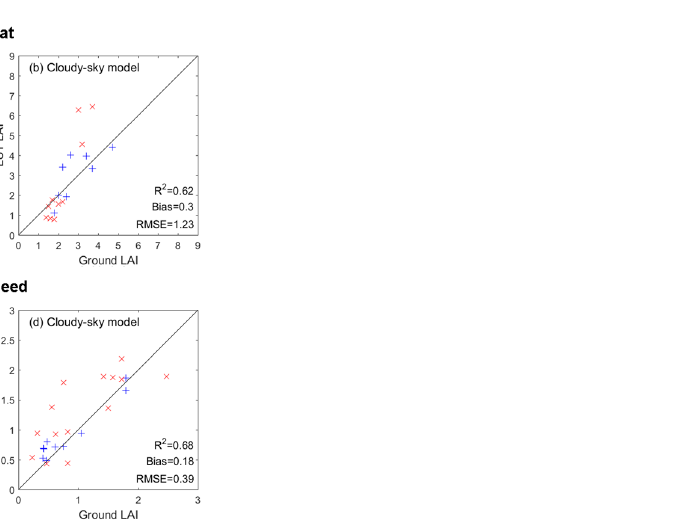
Figure 5. The comparison between inverted LAI and ground measured LAI for wheat and rapeseed. ( a , c ) All the points are inverted from direct model only, ( b , d ) points under clear conditions were inverted by direct model, and points under cloudy conditions were inverted by diffuse model.